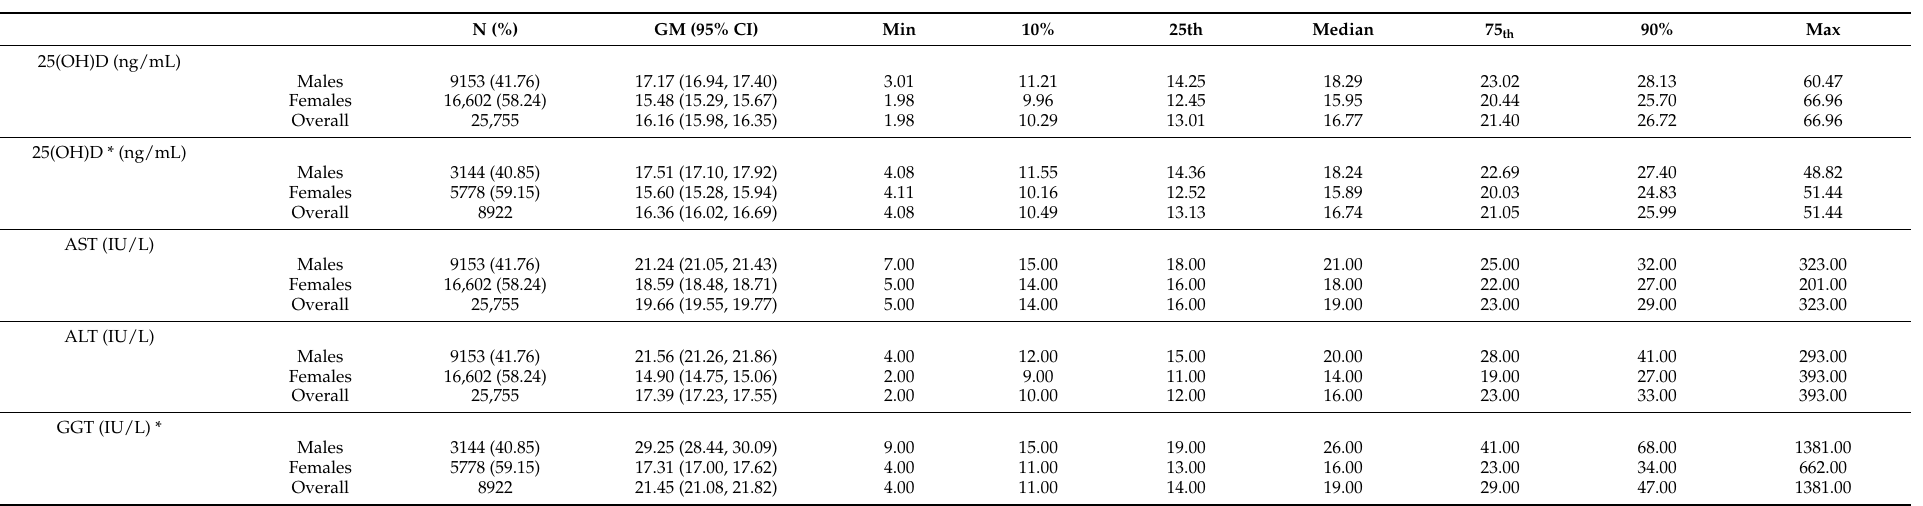
Table 2. Distribution of serum 25(OH)D levels and serum liver enzymes in the study population KNHANES